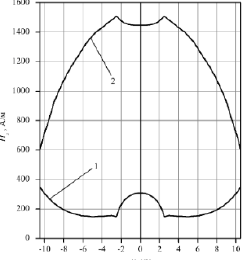
Fig. 5. Distribution of the normal component of the magnetic field intensity above the samples with a welded seam: non- ferromagnetic block (1); ferromagnetic block